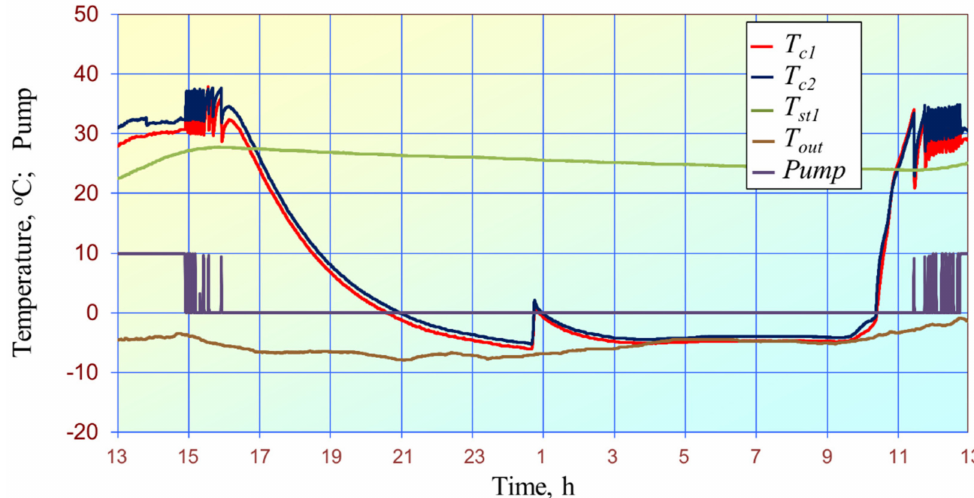
Figure 20. Nighttime control for the solenoid valve (21–22 November